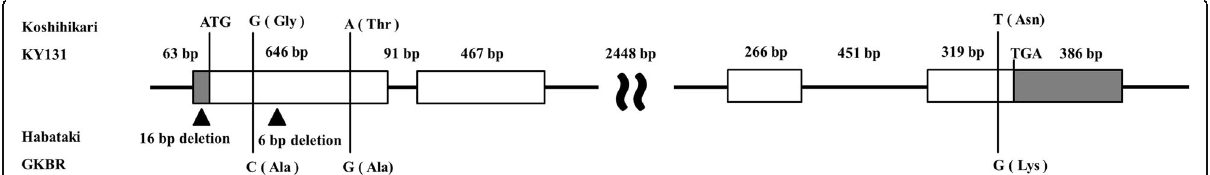
Fig. 1 Gn1a structure and allelic variation of Kongyu 131, GKBR, Koshihikari and Habataki. Three SNPs in the coding sequence that resulted in amino acid changes (in parentheses) were identified and are shown as black vertical lines. A 16-bp deletion in the 5 ′ -untranslated region and a 6-bp deletion in the first exon were identified and are shown as triangles. Gray and white rectangles and black horizontal lines represent untranslated regions, exons and introns,